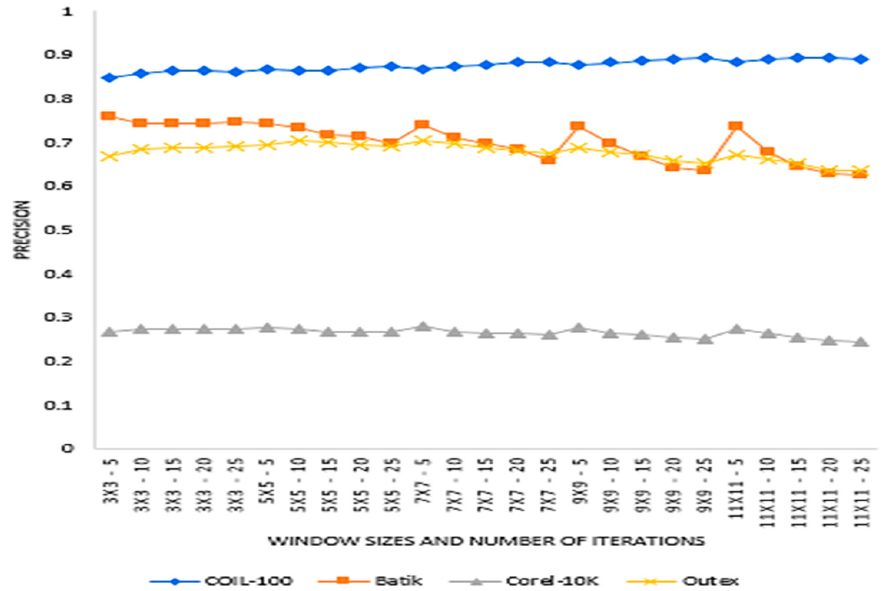
Figure 3. Average precision for various window sizes and the number of transformations for the four datasets.